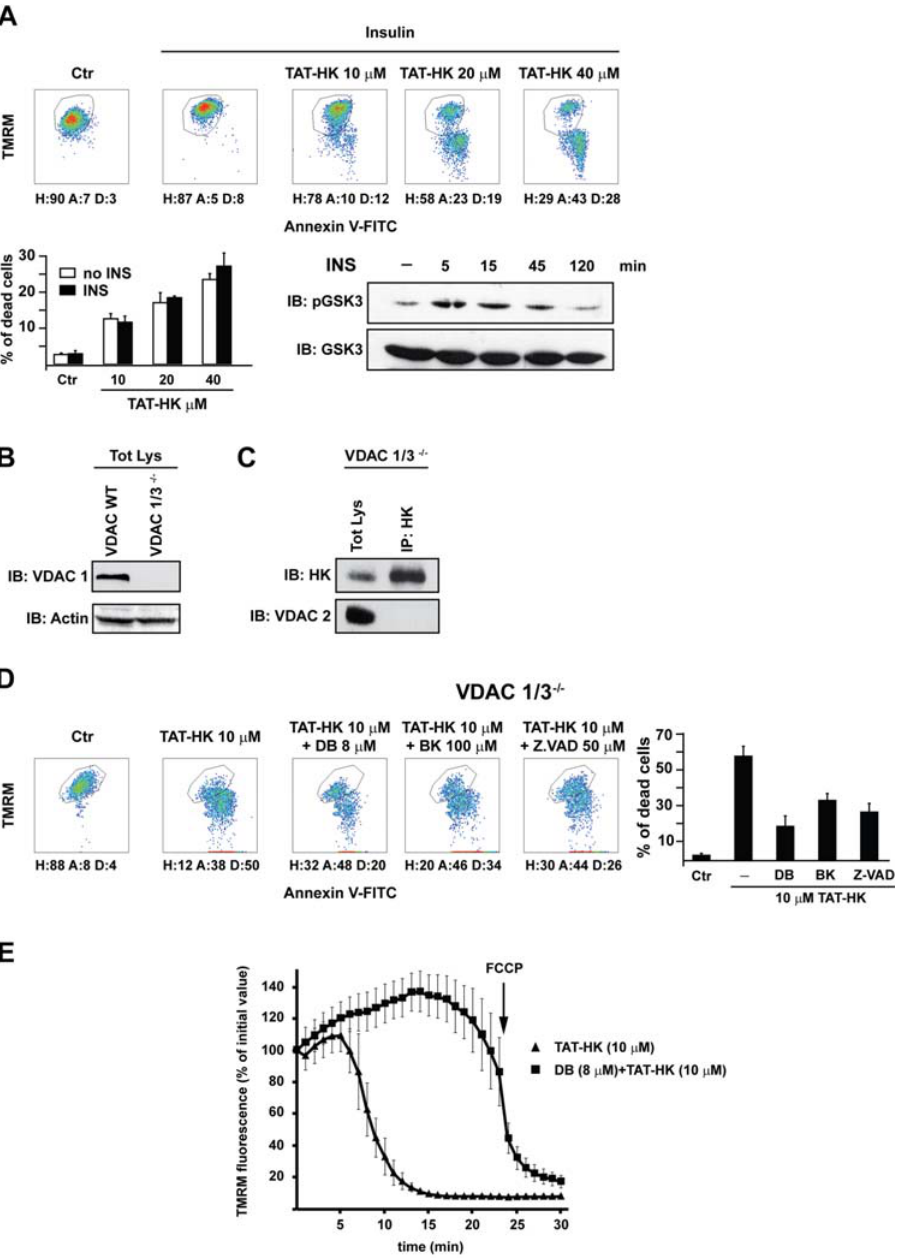
Figure 6. Neither insulin nor VDAC modulate apoptosis triggered by detachment of HK II from mitochondria. (A) After 10 minutes of insulin (5 m g/ml) stimulation, HeLa cells were exposed for 2 hours to the reported concentrations of TAT-HK and apoptosis assayed as in Figure 1B. Western immunoblot shows GSK3 b inhibition ( i.e. Ser9 phosphorylation) by insulin. (B) HK II and VDAC expression in MEF obtained from either wild- type or VDAC 1/3 knock-out mice were assessed by Western immunoblot. VDAC expression was checked with an anti-VDAC1antibody, protein loading with an anti-actin antibody. (C) Immunoprecipitation of HK II and rehybridization with an anti VDAC2 in VDAC1/3 knock-out MEFs. (D) Output of multiparametric FACS analyses show apoptosis induction in VDAC1/3 knock-out MEFs. Cells were exposed for 1 hour to the stated concentrations of TAT-HK with or without pre-incubation with Debio 025 (DB, 8 m M), bongkrekate (BK, 100 m M) or Z.VAD-fmk (50 m M). Diagrams and percentages of the different cell populations are indicated as in Fig. 1B. (E) Mitochondrial depolarization after cell treatment with TAT-HK (10 m M) with or without pre-incubation with Debio 025 (8 m M), as assessed by decreased TMRM staining by epifluorescence microscopy. All reported measurements are representative of at least four